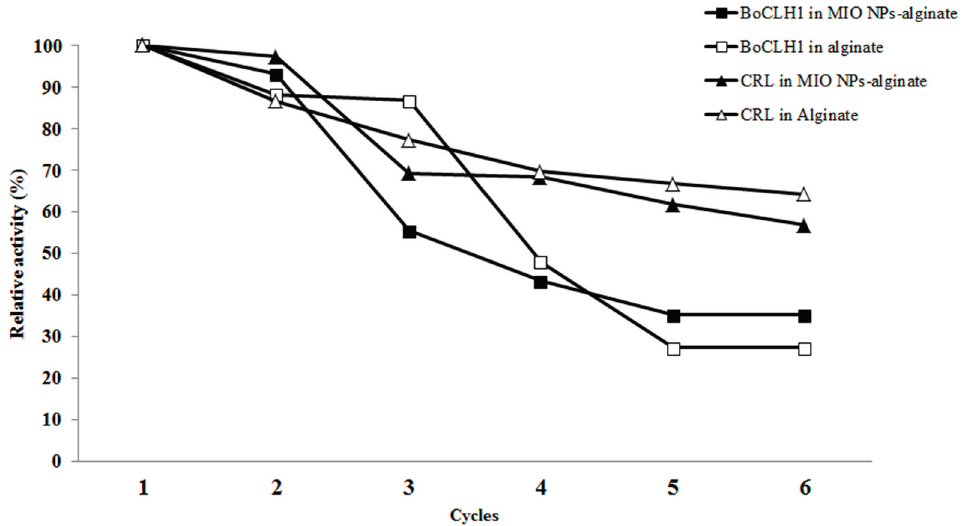
Figure 7. The residual activity of the BoCLH1 in the alginate ( □ ) and MIO NP-alginate ( ■ ) and CRL entrapped in the alginate ( ∆ ) and MIO NP-alginate ( ▲ ) at pH 6 in reaction buffer for 30 min each